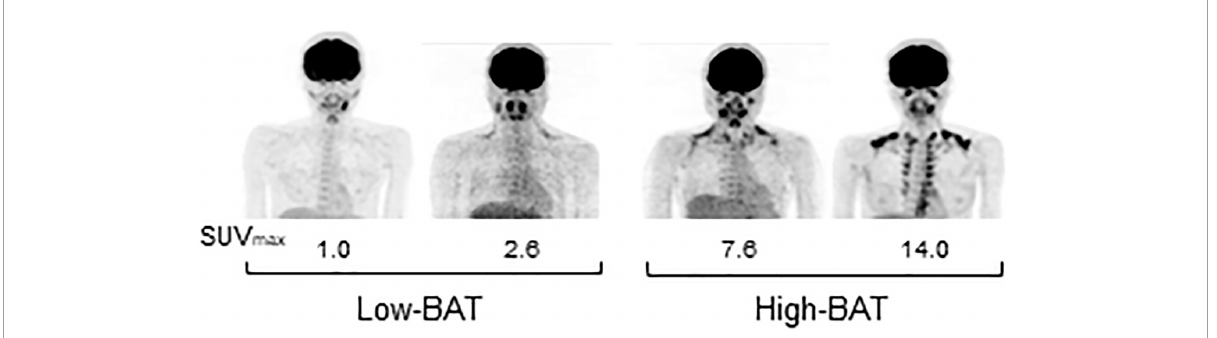
FIGURE1 FDG-PET images of participants in the Low- and High-BAT groups. PET/CT was performed after 2-h cold exposure, and [ 18 F]FDG uptake into the supraclavicular BAT was quantified as the maximal standardized uptake value (SUV max ).